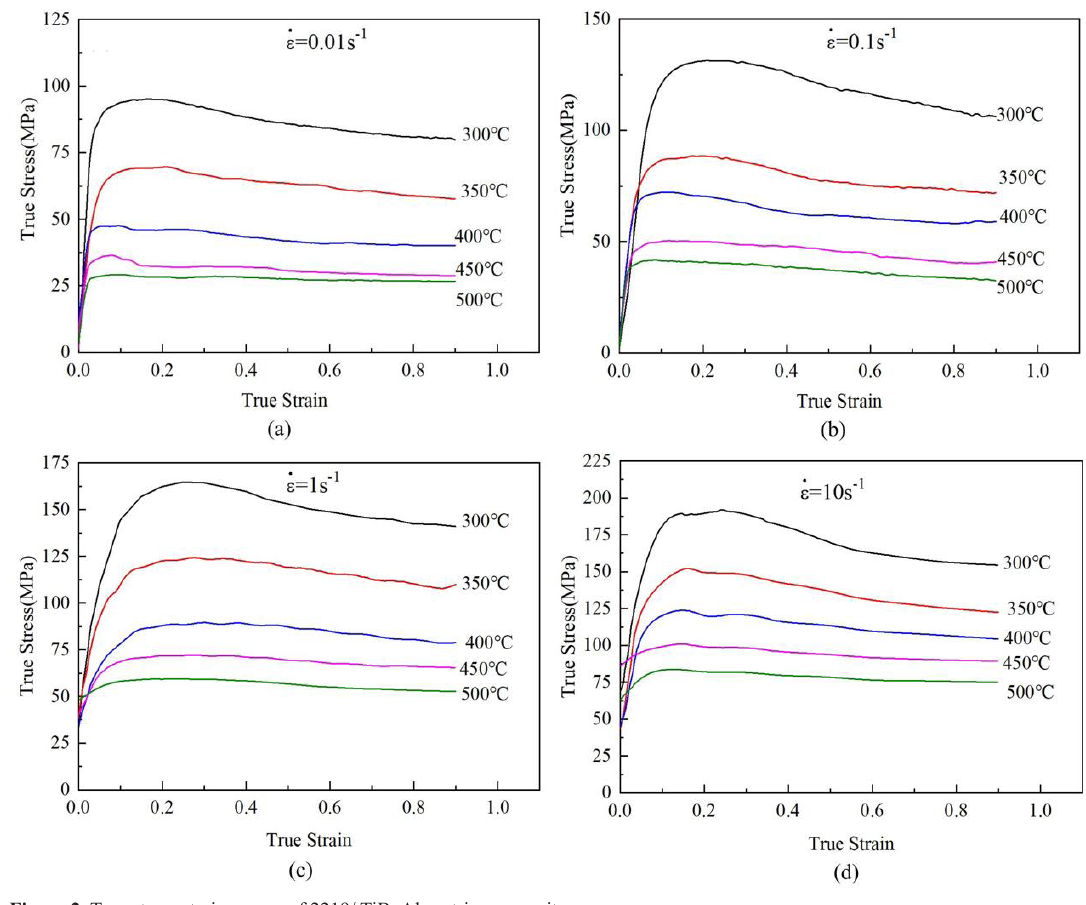
Figure 2. True stress strain curves of 2219/ TiB